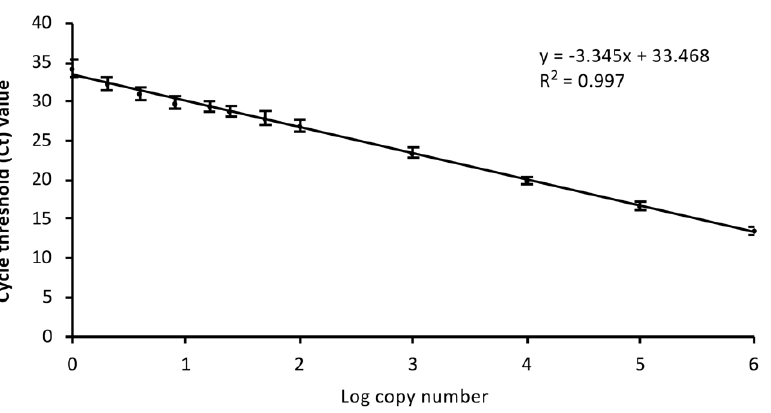
Figure A1. Standard curve obtained using dilutions of the plasmid DNA ranging from 10 6 to 2 copies per reaction. Linear regression was performed on mean data from three separate runs.